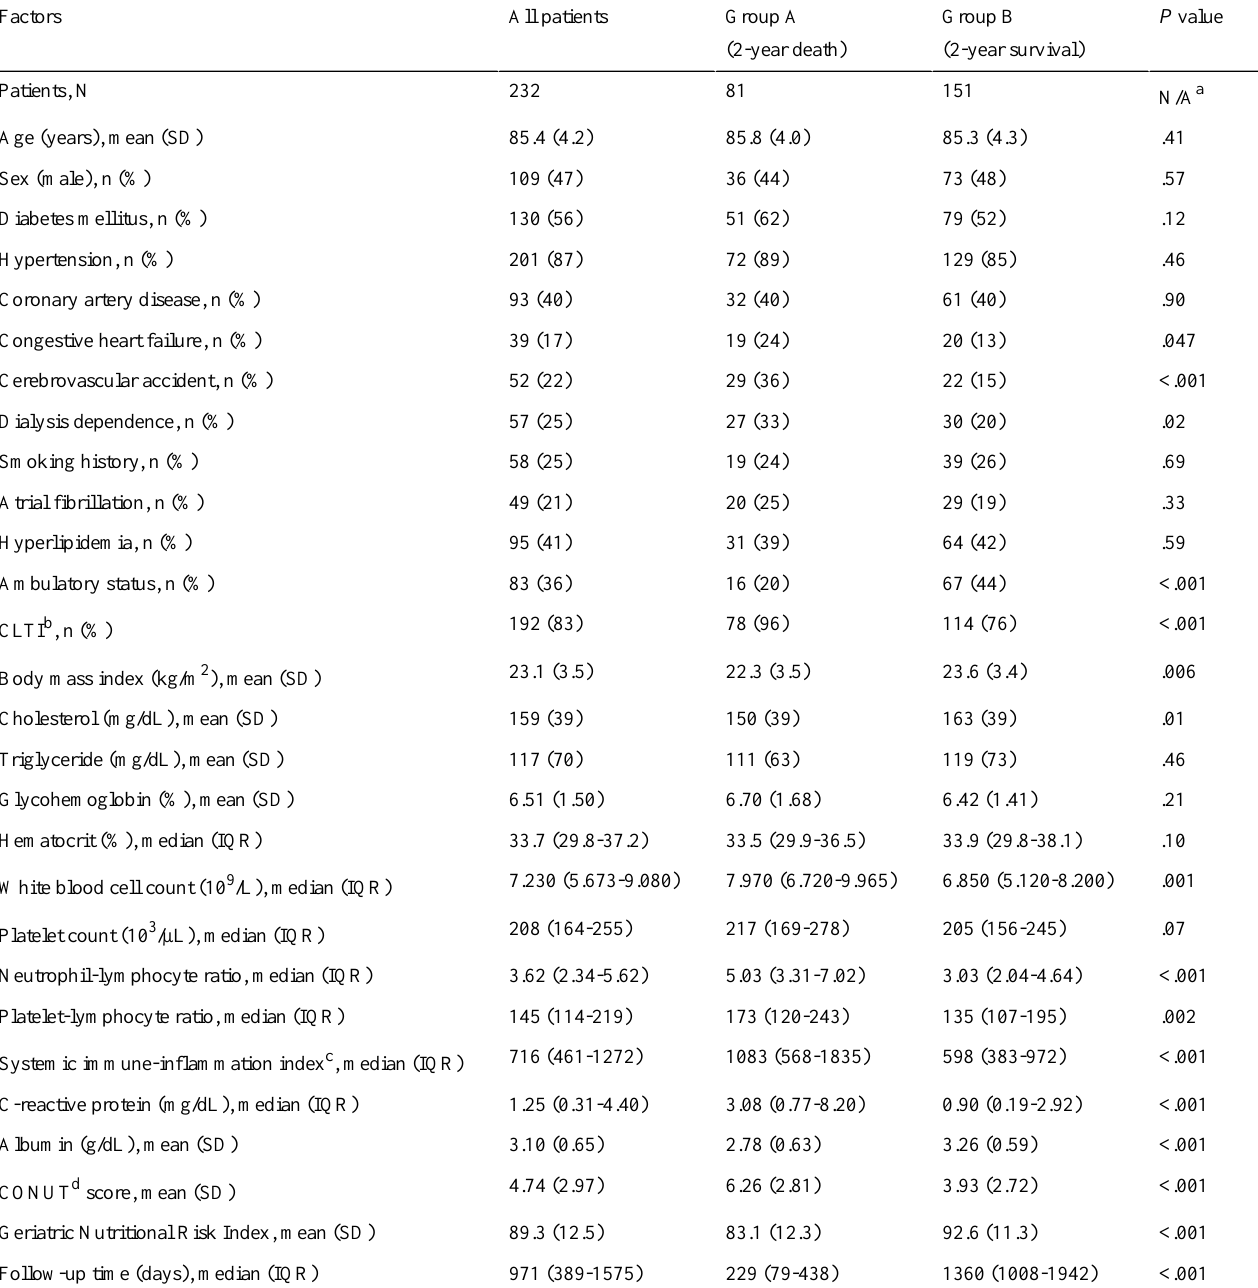
Table 1. Patient demographics.